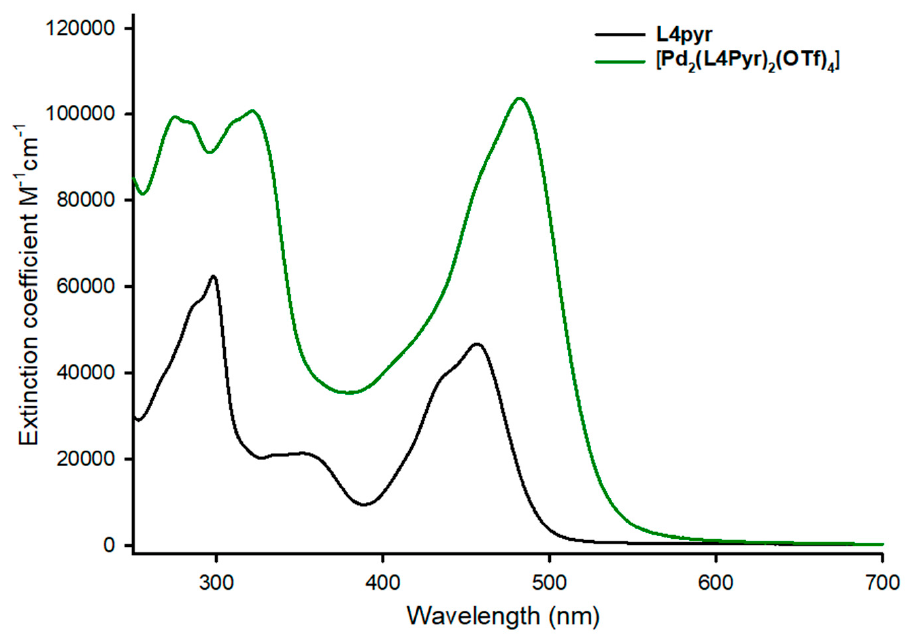
Figure 5. UV-vis absorption spectra of ligand L4Pyr and metalla-macrocycle [ Pd 2 (L4Pyr) 2 (OTf) 4 ], r.t. (C = 1.5 × 10 − 5 M in CH 2 Cl 2 ).